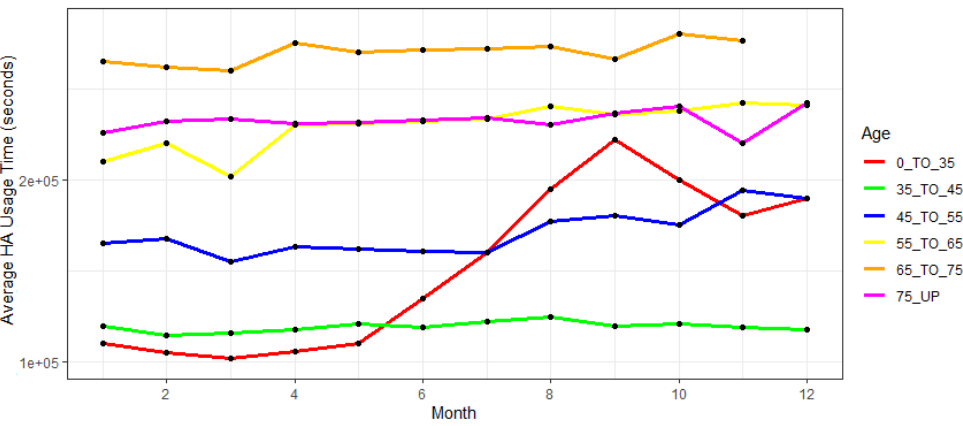
Figure 4. Average HA usage per age group per month.